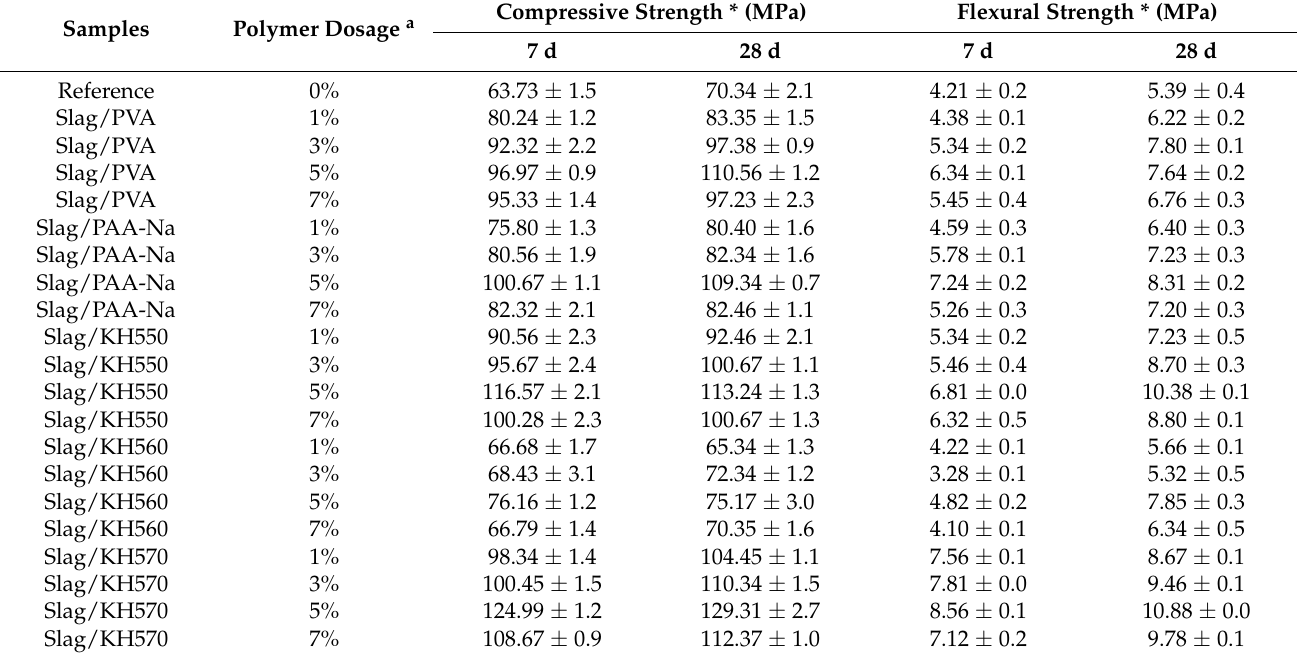
Table 3. The compressive strength and flexural strength of organic–inorganic composite